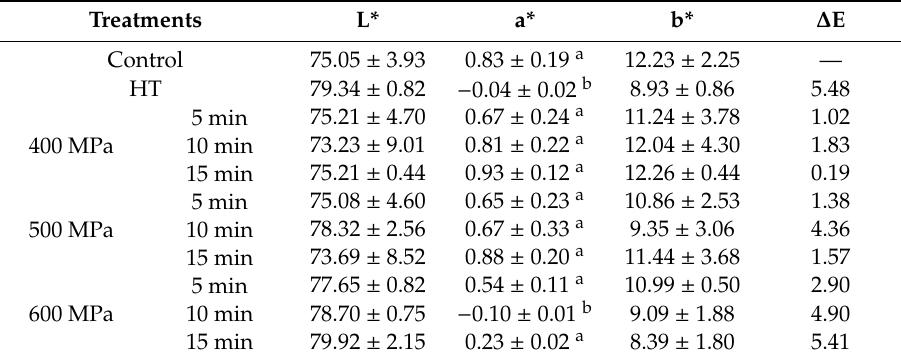
Table 2. Color of kiwifruit pulp beverage after HHP treatment on day 0.